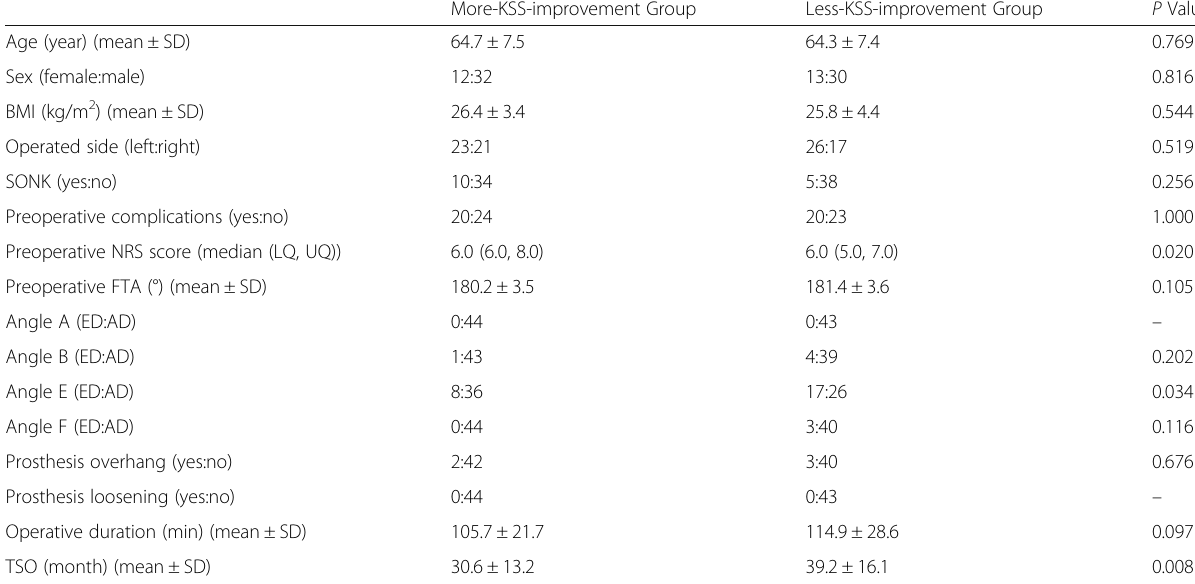
Table 2 Clinical characteristics of the more-KSS-improvement group and the less-KSS-improvement group More-KSS-improvement